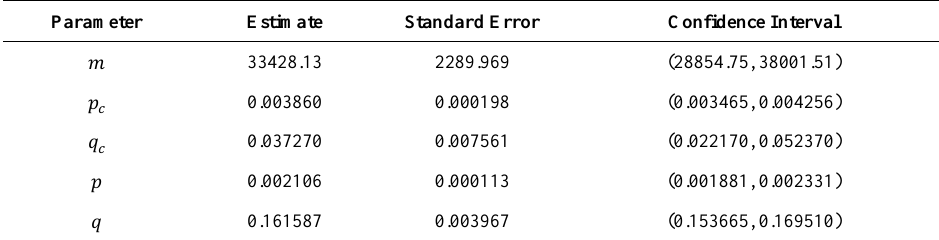
Table A27. Emilia–Romagna. Estimates, asymptotic standard errors and 95% mCIs for the parameters of the DMP (8).